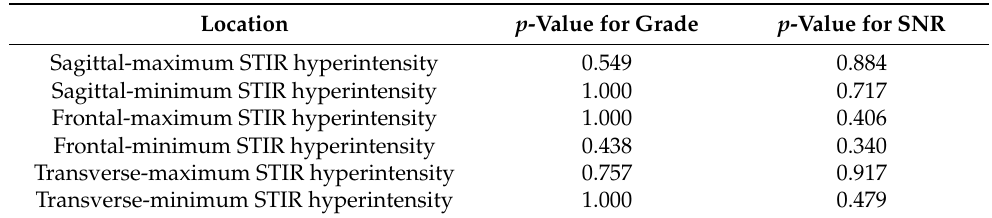
Table 3. Test of statistical difference between unblinded fresh and thawed STIR hyperintensity grades and SNR values for sagittal, frontal and transverse STIR sequence